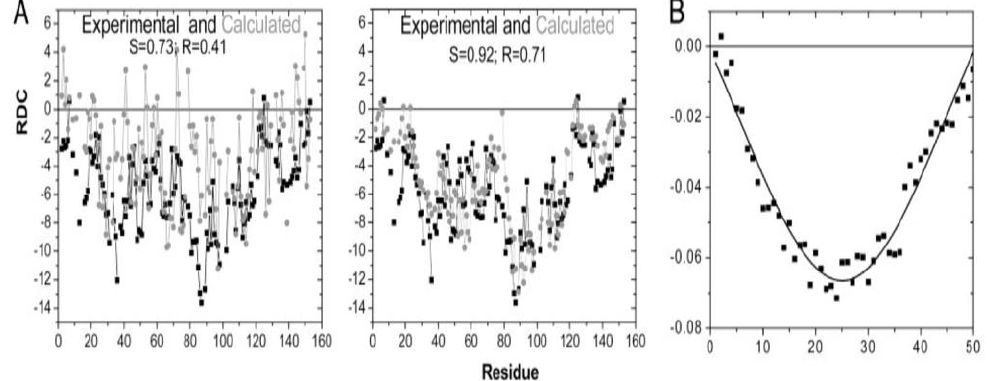
Figure 6. ( A ) Experimental (black) and calculated (grey) residual dipole coupling values for apo- myoglobin in 10% acrylamide. The employed model combined coil library data with MD simulations. Left : Calculations performed without considering NNIs. Right : Calculations performed with NNIs obtained from a comparison of Ramachandran plots. ( B ) Residual dipole coupling values of an idealized random coil ensemble of an A 50 polypeptide generated without nearest neighbor coupling. Equal population (1/3) was assumed for pPII, β-strand and right-handed helical basins. Taken from [18] (free-access article).